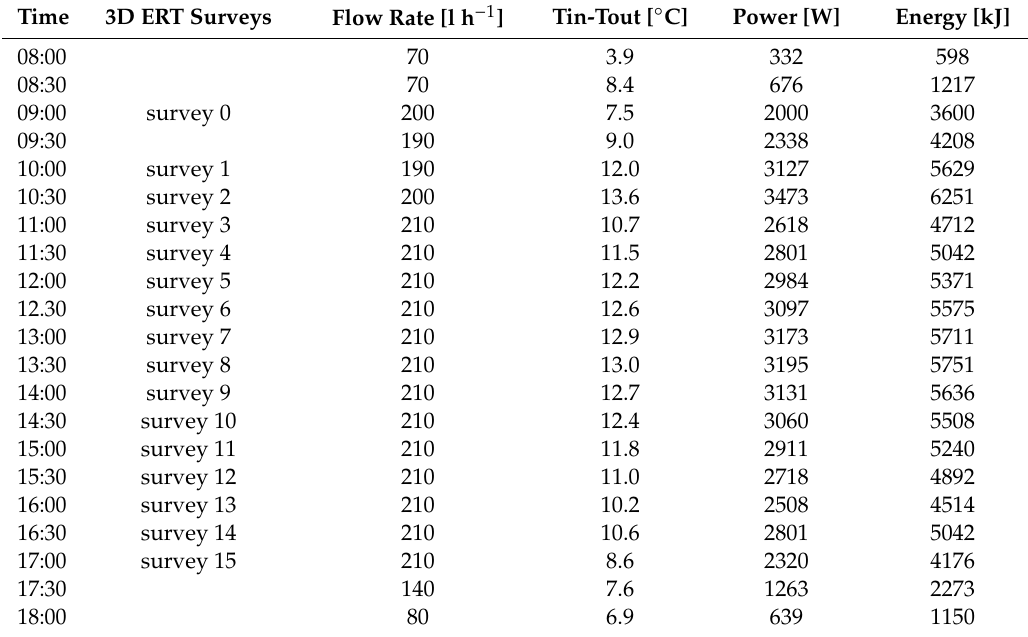
Figure 2. Meshing around the borehole heat exchangers (BHEs) in the FeFlow modelling environment with evidence (orange lines) of the connection between the BHEs related to the plant’s operation system; within BHEs red pipes are inflow, blue pipes are outflow. Table 1. System’s data collected during 31st July. Time of 3D ERT surveys is also